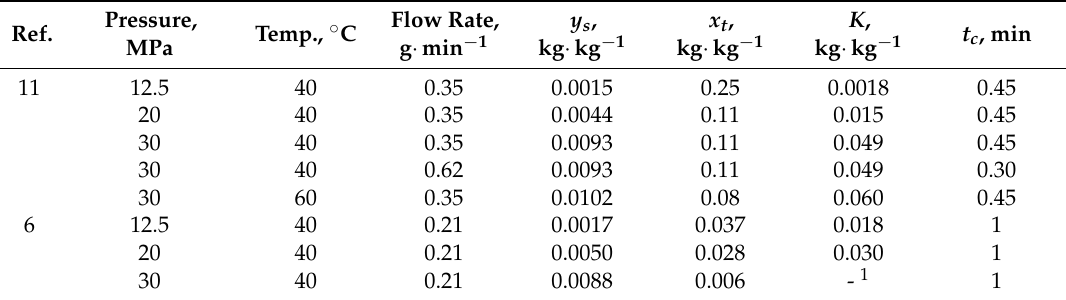
Table 2. Model parameters for the extraction of oil from Nannochloropsis species [11] ( N = 1.25